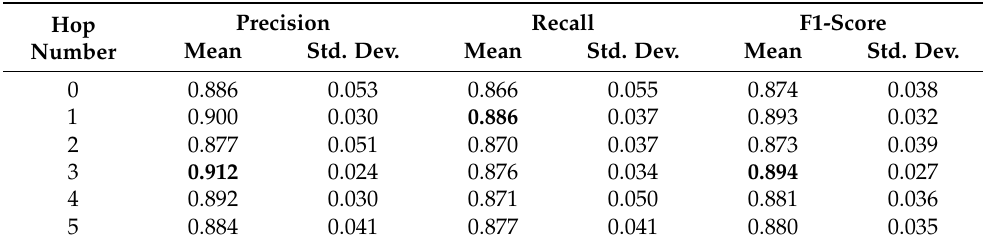
Table 5. Performance comparison of different diffusive hops. Means and standard deviations of the three metrics are presented.